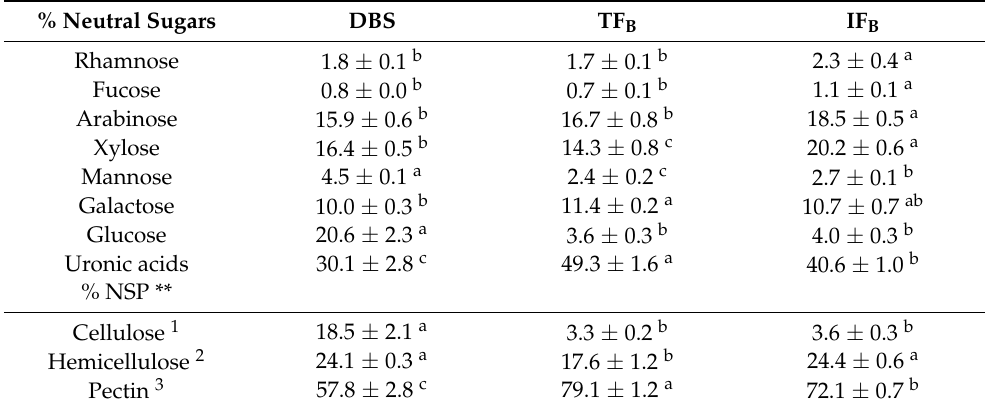
Table 2. Proportions of neutral sugars, uronic acids, cellulose, hemicellulose and pectin in different samples obtained from broccoli stalk, expressed as percentages (%)